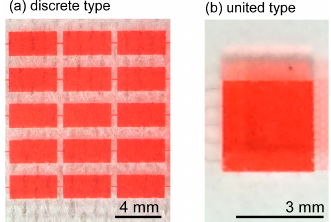
Figure 8. Cell culture microchamber. ( a ) Discrete-type chamber for investigating cell behaviors in glucose solutions with uniform concentration; ( b ) United-type chamber for investigating cell behaviors in glucose solutions with a concentration gradient.